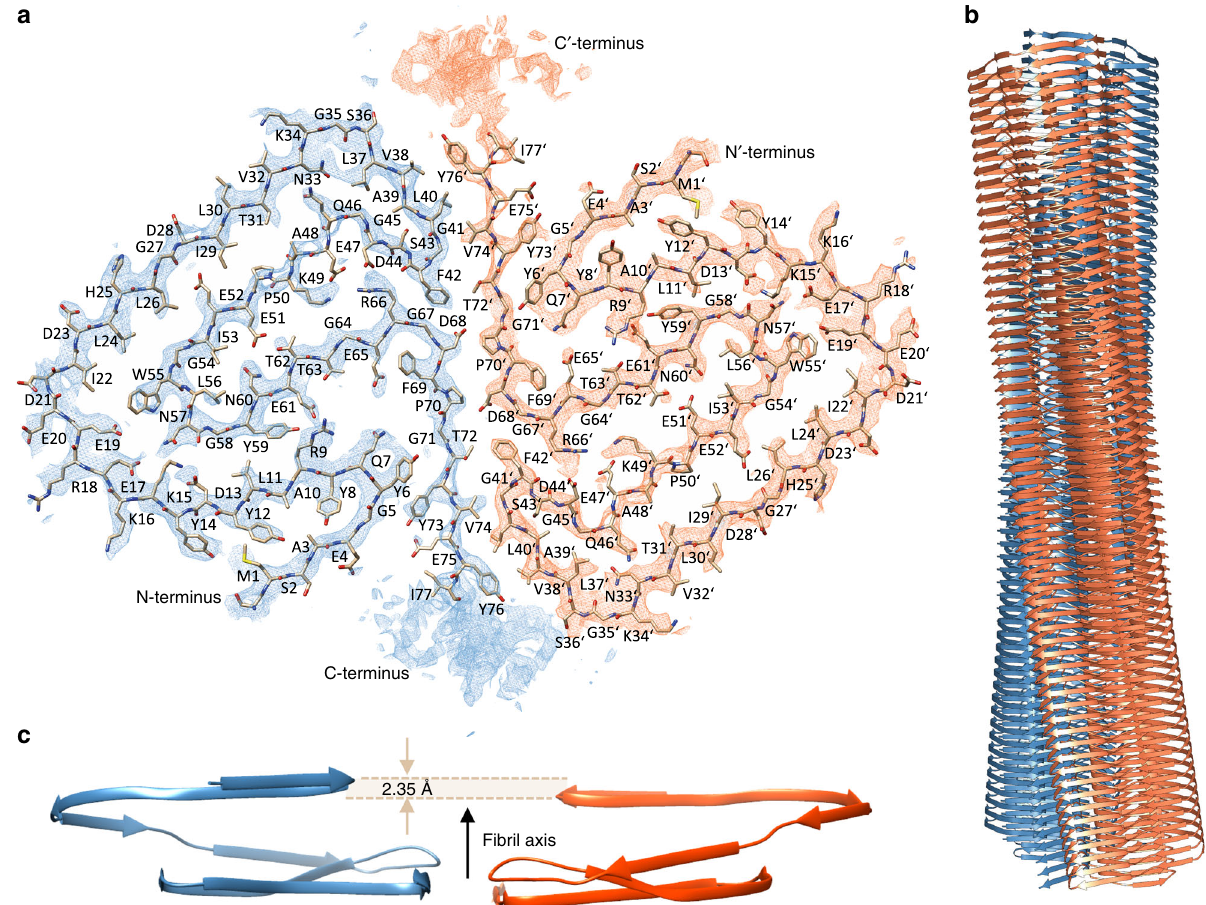
Fig. 1 Double Filament SH3 fi bril structure. a Cross-section of the double fi lament (DF) PI3K-SH3 fi bril (two monomers). The different proto fi laments are colored blue and orange. Density maps are shown at a contour level of 1.4 σ . The density map was suf fi ciently clear to model residues 1 – 77. b Side view of fi laments twisting around each other displaying a total of 125 layers. c Relative arrangement of two adjacent PI3K-SH3 monomers within the fi bril, showing